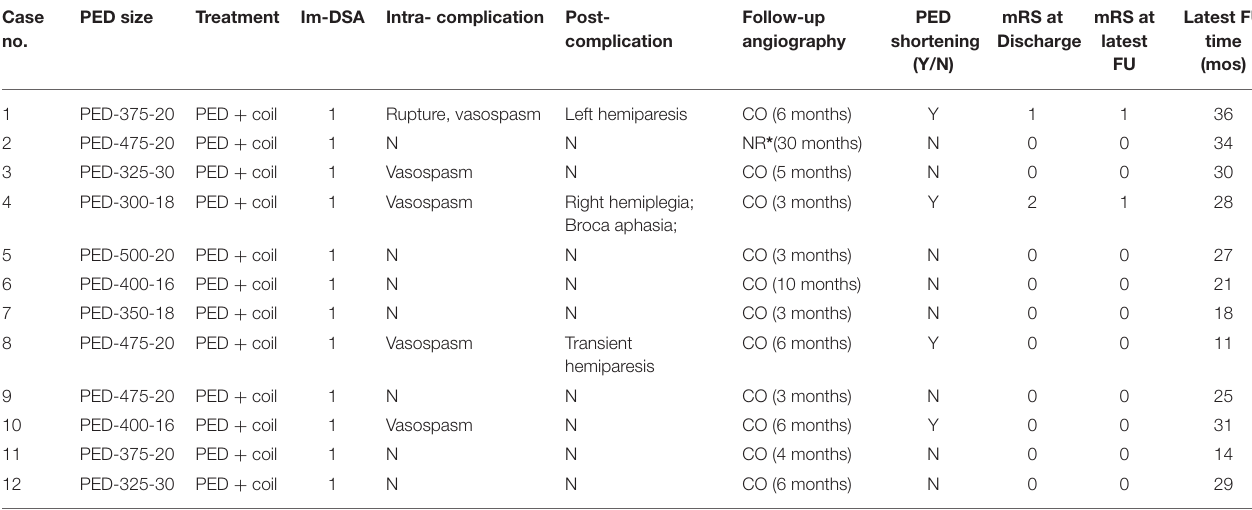
TABLE 2 | Summary of clinical and angiographic outcomes of patients treated by PED-assisted coil embolization. Case